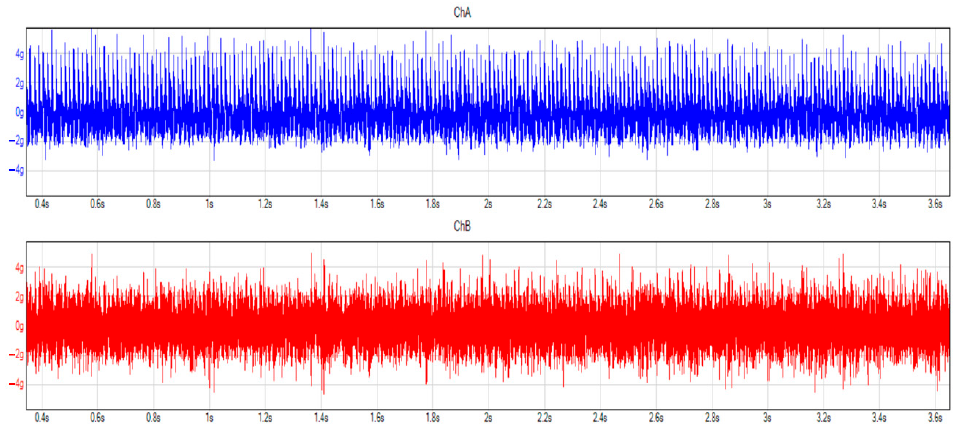
Figure 13. Vibrations in time domain before the oil change, 50 km/h, 3rd gear. Blue and red colors mean the different considered and applied channels, during the measurement.